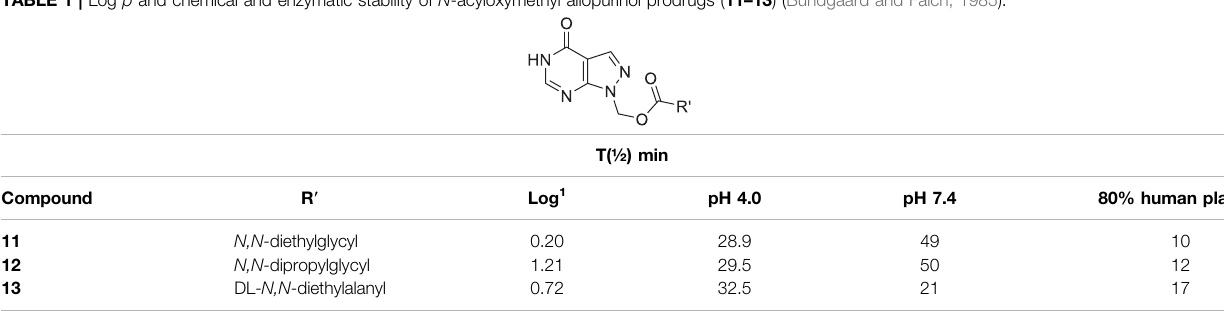
TABLE 1 | Log p and chemical and enzymatic stability of N -acyloxymethyl allopurinol prodrugs ( 11 – 13 ) (Bundgaard and Falch,